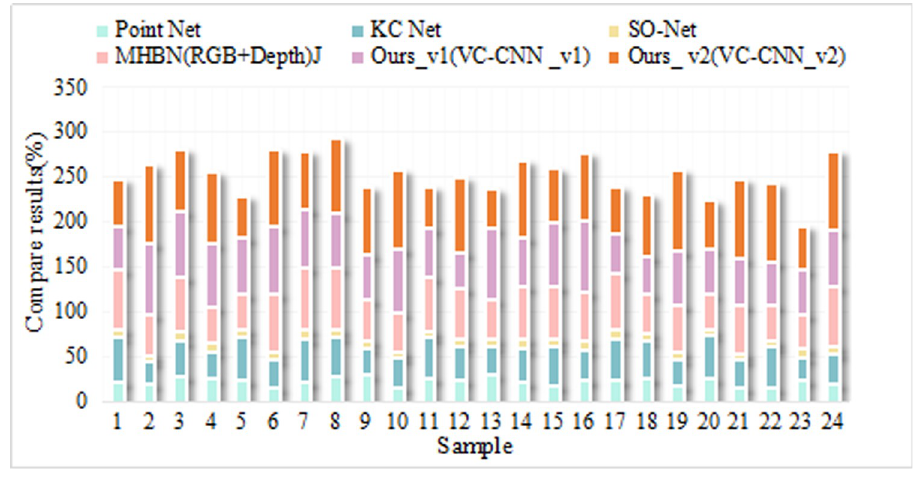
Fig 8. The result of factor analysis.